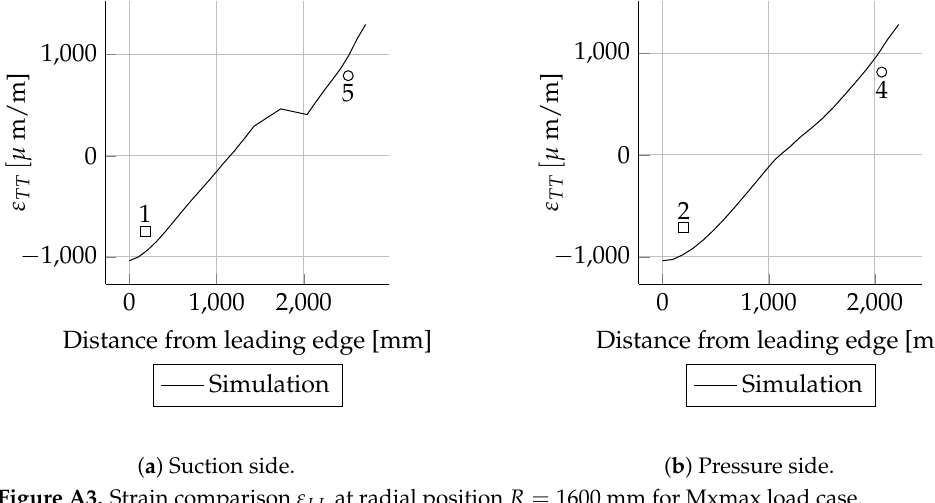
Figure A3. Strain comparison ε LL at radial position R = 1600 mm for Mxmax load case.